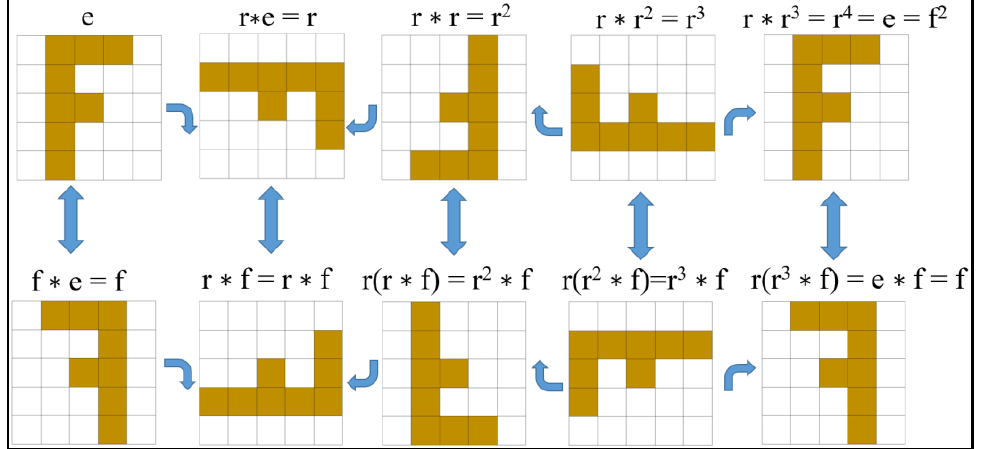
Figure 2. Dih 4 transformations.